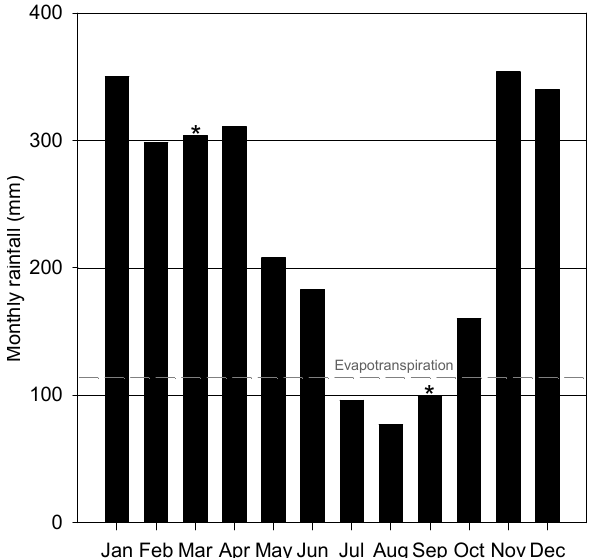
Fig. 1. Average monthly rainfall over 24-year record (1984–2006) in Central Kalimantan. Data presented is the lower 50-percentile of the driest years (1983, 1990, 1991, 1994, 1996, 1997, 1999, 2000, 2001, 2002, 2004, 2006). Dashed line represents the average evap- otranspiration over the same time period. All data collected from Palangka Raya Meteorological Office (Hooijer et al., 2008). ∗ Denotes timing of the two sampling